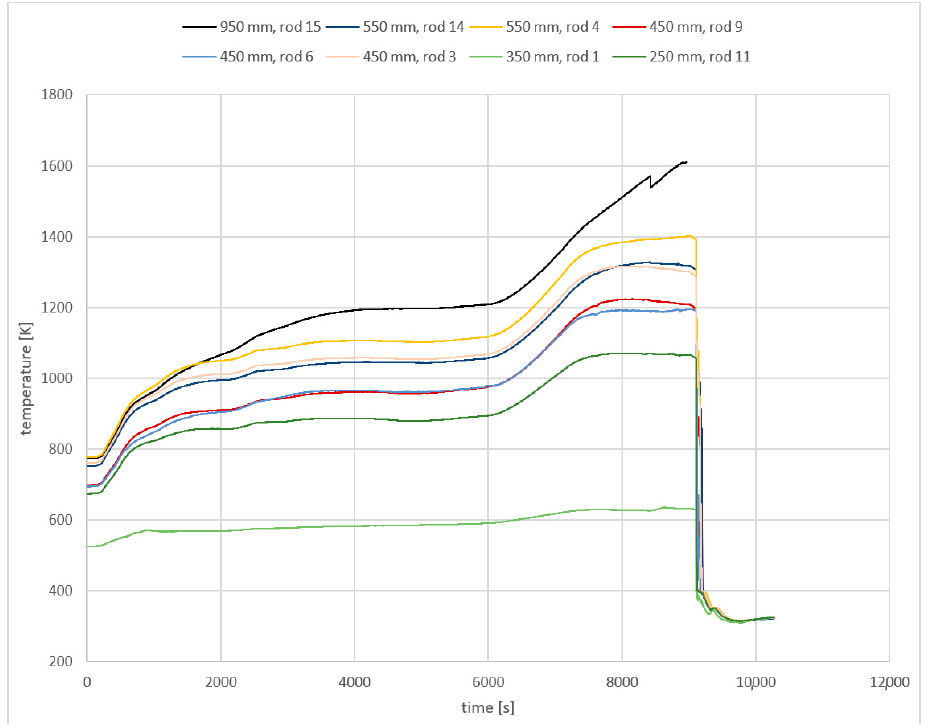
Figure 9. Temperatures measured in the heated part of the bundle and the central ring, 1/2 (axial level, rod) [12]. Energies 2023 , 16 , x FOR PEER REVIEW